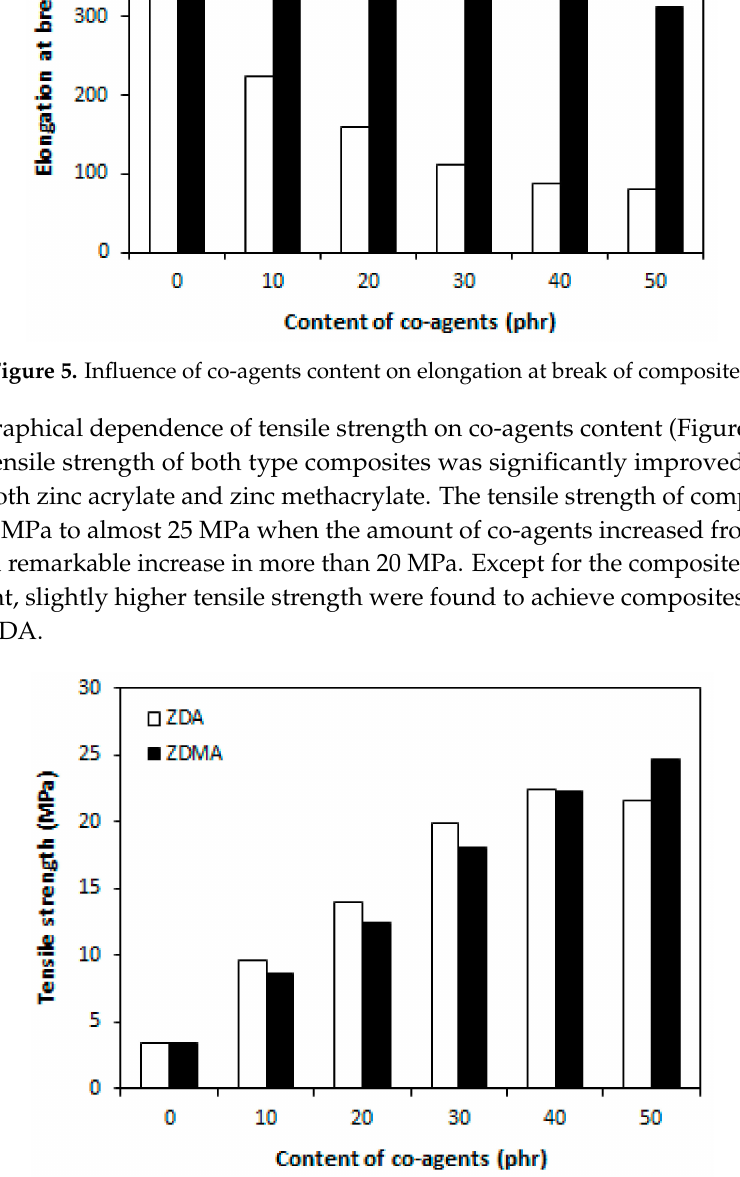
Figure 6. Influence of co-agents content on tensile strength of